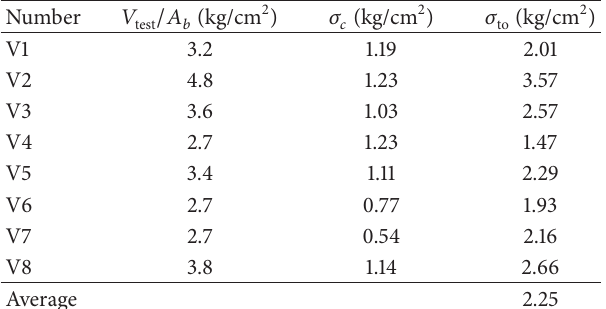
Table 2: Mortar shear stress of infill